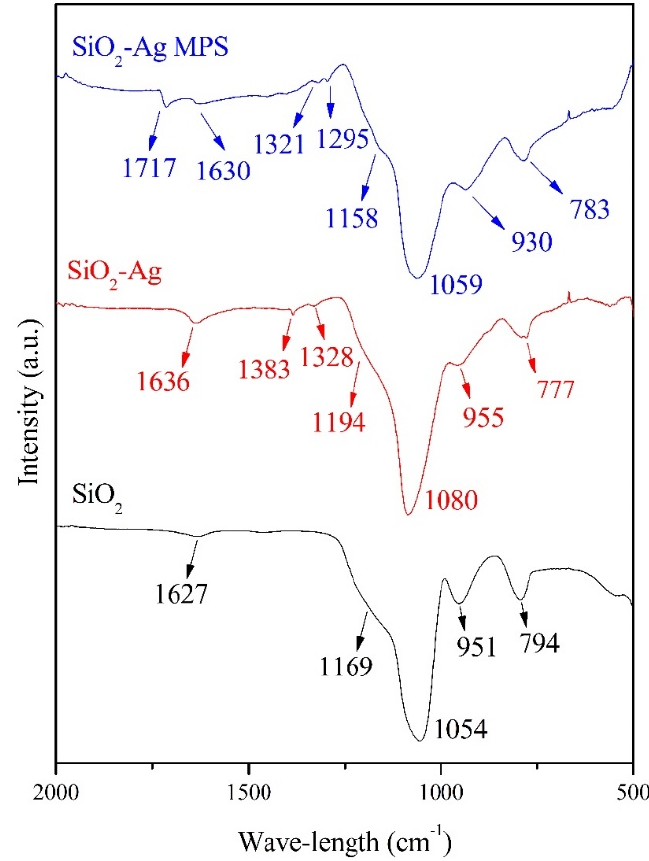
Figure 4. FT-IR spectra of SiO 2 , SiO 2 -Ag, and SiO 2 -Ag-MPS nanoparticle samples from 2000 to 500 cm − 1 .